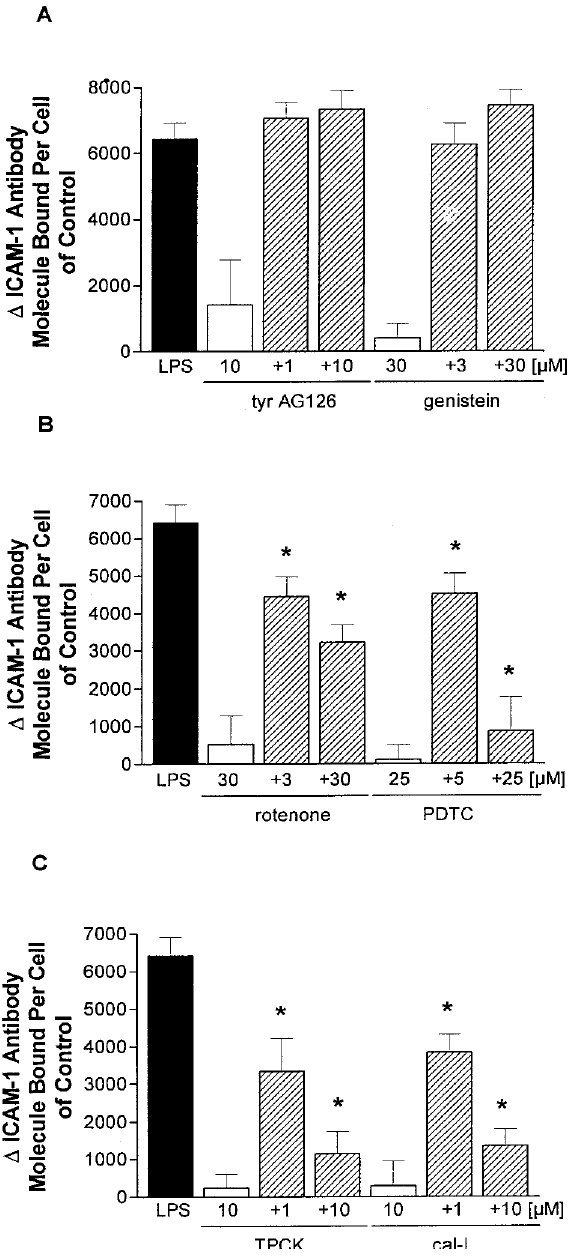
FIG. 2. Effect of (a) tyrphostin AG126 (tyr AG126) or genistein, (b) rotenone or pyrrolidine dithiocarbamate (PDTC), (c) L-1-tosylamido-2-phenylethylchloromethyl ketone (TPCK) or calpain inhibitor I (cal-I) on the increase in the expression of ICAM-1 on the cell plasma membrane of J774.2 macrophages activated with LPS (1 m g/ml) for 4h. J774.2 cells were incubated with the drugs in the absence (open columns) or presence (hatched columns) of LPS. Data are expressed as mean±S.E.M. from triplicate determina- tions (wells) from three separate experimental days ( n =9) and are expressed as D ICAM-1, the basal value (without LPS or drugs) being subtracted. * P <0.05 represents significant difference when compared to LPS-controls (solid column).